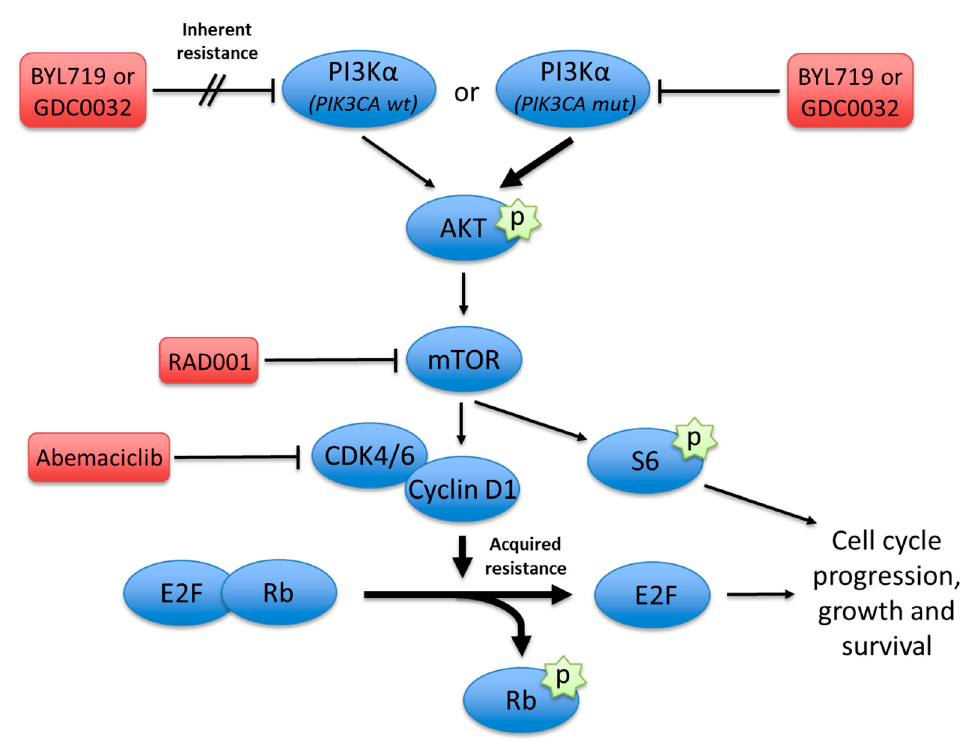
Figure 1. Graphical abstract depicting the mechanisms of inherent and acquired resistance to PI3K inhibition at different vertical nodes along the PI3K/Akt/mTOR pathway. Activating mutations and copy number amplifications in PIK3CA result in marked upregulation of PI3K α signaling. Acquired resistance develops via activation of the CDK 4/6–cyclin D1 complex that may be blocked simultaneously to overcome this resistance. Alternatively, mTOR inhibition may synergize downstream with PI3K α inhibition. Conversely, PIK3CA wild-type tumors are independent of PI3K α activity, which makes them inherently resistant to PI3K α inhibition. Hence, combining additional inhibition along the pathway may overcome this resistance and improve the efficacy of PI3K inhibitors.